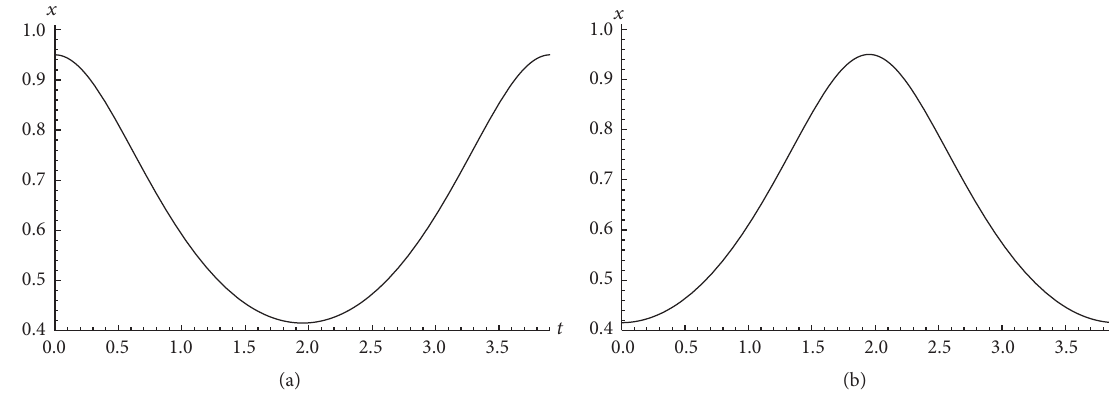
Figure 8: (a) Exact periodic solution 𝑥 in (52) for 𝑎 1 = −1 , 𝑎 5 = 3 , and 𝑥 0 = 19/20 = 0.95 and (b) 𝑎 1 = −1 , 𝑎 5 = 3 , and